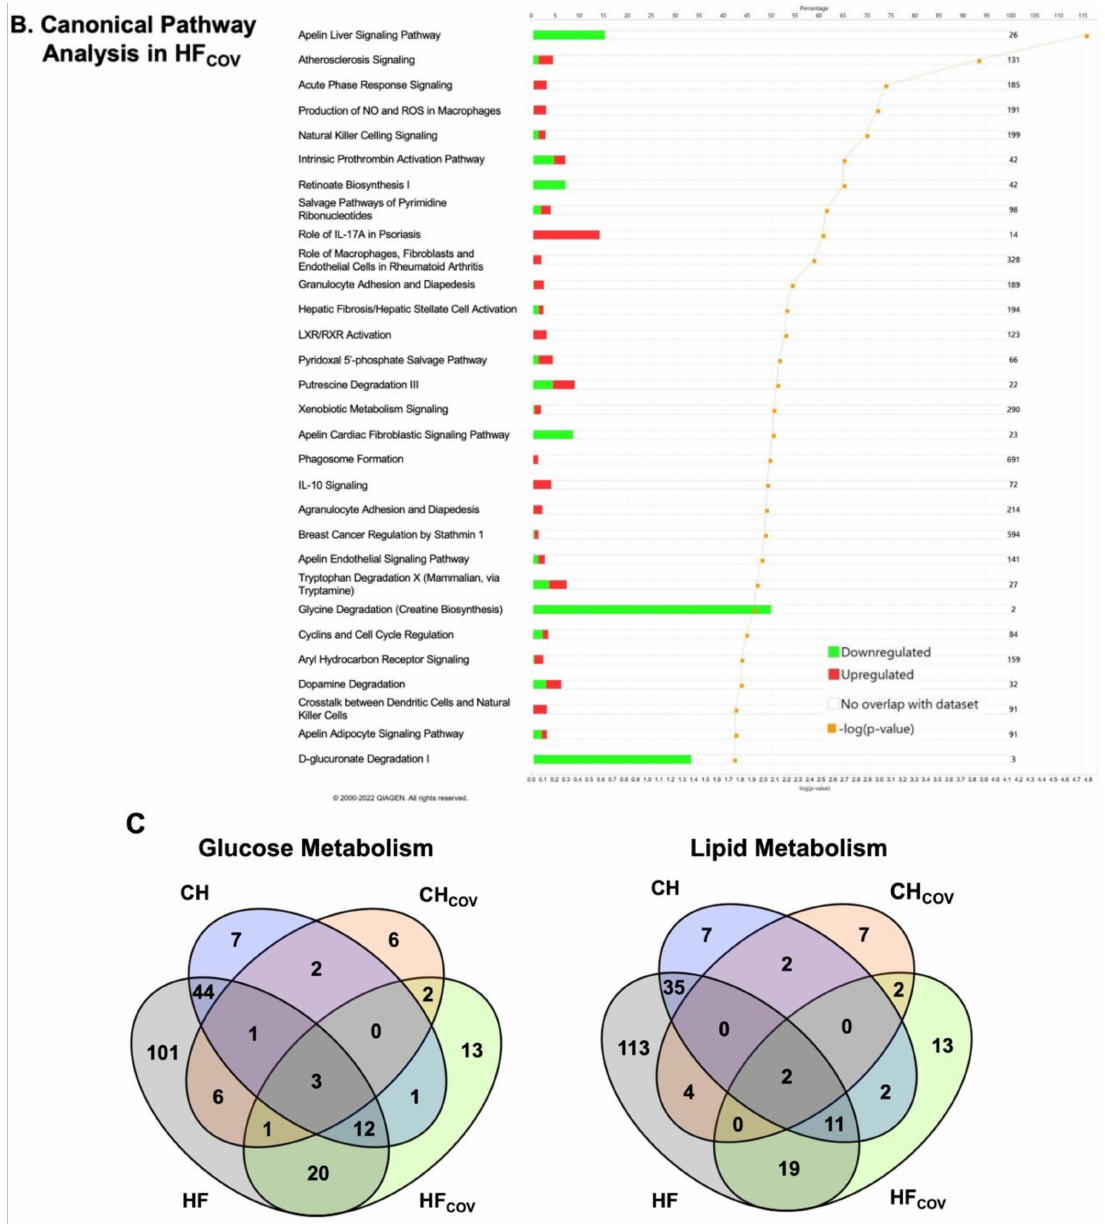
Figure 2. Transcriptomics analyses of rats with volume overload (VO) or with correction of VO. Pathway enrichment analyses of the differentially expressed genes (fold change > 1.5 and p < 0.05; ranked by − log [ p value] of each pathway) in VOed rats in the heart failure (HF) phase ( A ) and in VOed rats with correction of VO in the HF phase (HF COV ) ( B ); Venn diagrams ( C ) illustrating the number of differentially expressed genes involved in glucose and lipid metabolism in VOed rats in the compensated hypertrophic (CH)and HF phases and VOed rats with correction of VO in the CH (CH COV ) and HF phases (HF COV ). n = 4 per